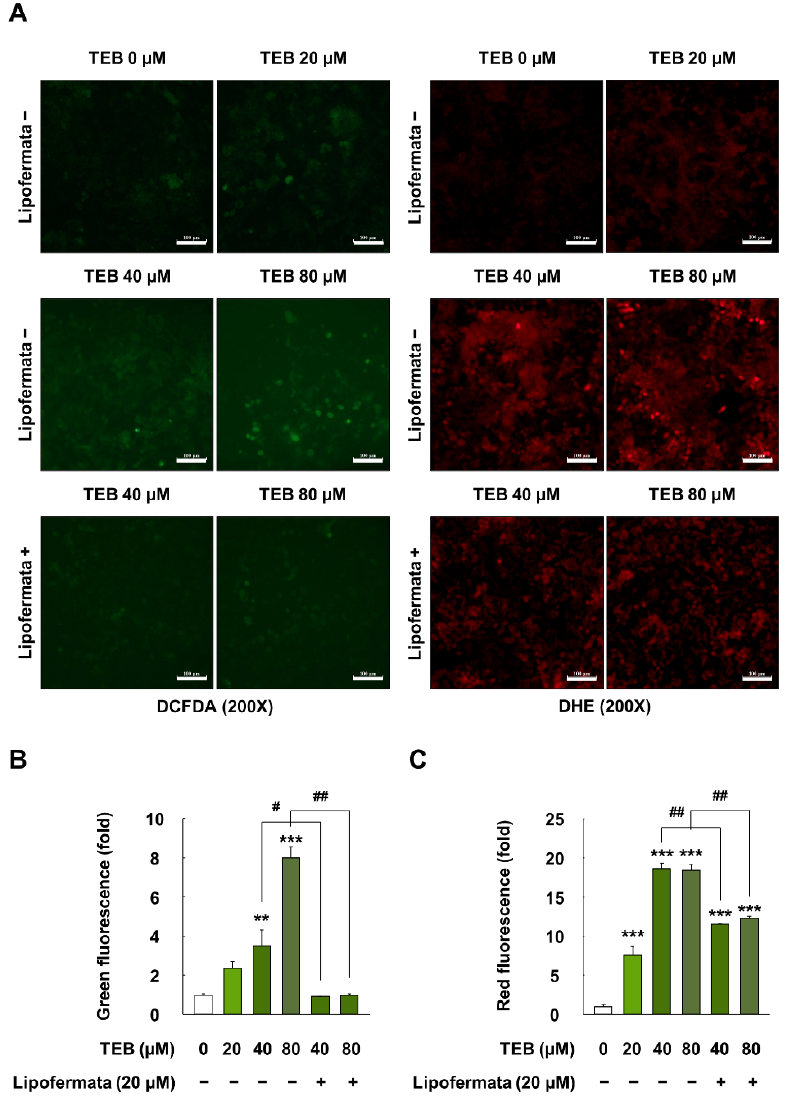
Figure 4. Oxidative stress measurements in HepG2 cells treated with TEB. ( A ) Fluorescence images of hydrogen peroxide (green) and superoxide (red) in cells (200× magnification, white bar = 100µm); quantification of the ( B ) green and ( C ) red fluorescence ratio in cells. Cells were exposed to 20, 40, and 80 µM TEB for 12 and 24 h with or without pretreatment with 20 µM Lipofermata for 1 h ( n = 3 wells/group). The data are represented as mean ± SEM. ** ( p < 0.01) and *** ( p < 0.001) show a significant difference, compared to the control (DMSO). # ( p < 0.05) and ## ( p < 0.01) show a significant difference, compared to the TEB-treated cells.